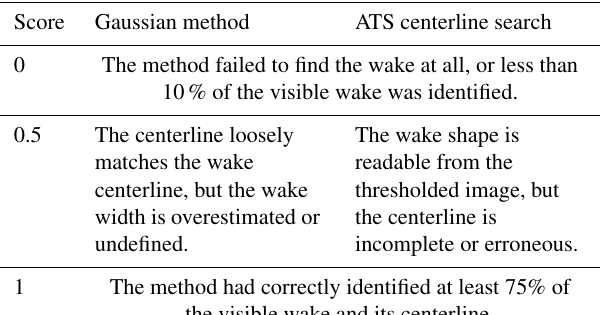
Table 4. Rules for scoring Gaussian and ATS centerline search method